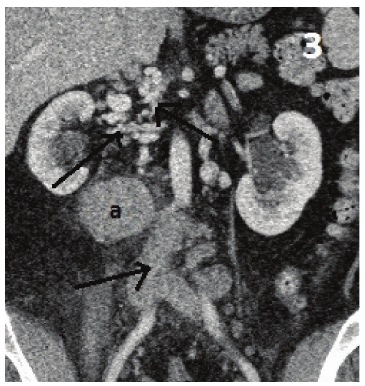
Figure 3: Abdomen CT coronal view: (a) IVC venous varix. Arrows pointing enlarged, multiple retroperitoneal/paralumbar collateral veins.